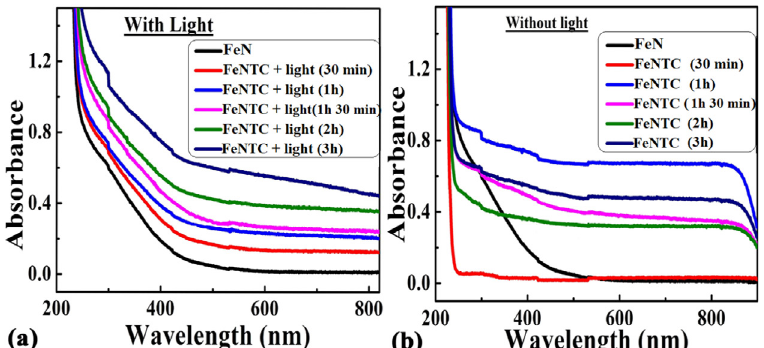
Fig. 1. Absorbance spectra of ferric nitrate treated with nanocomposite (a) under light irradiation; (b) without light irradiation.